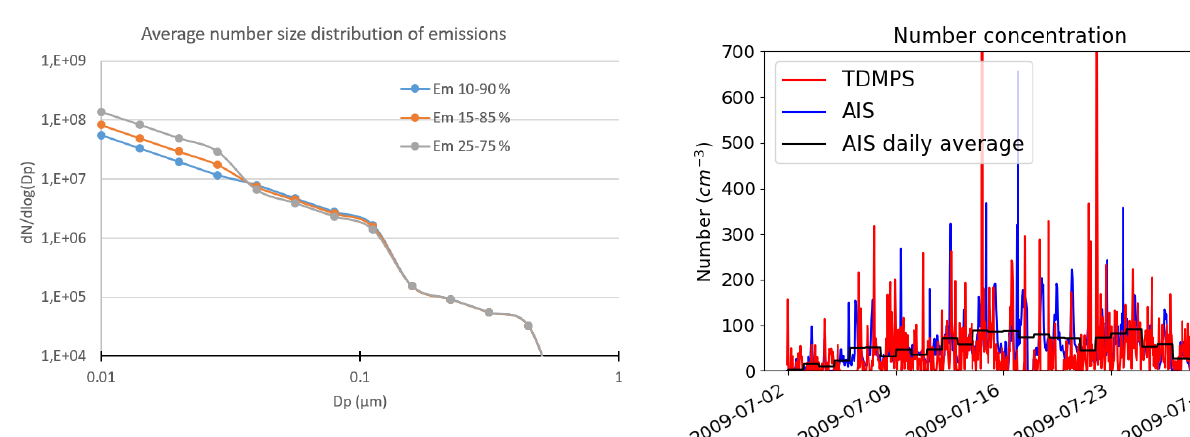
Figure 1. Number of emitted particles as a function of diameter (in m − 2 s − 1 ).